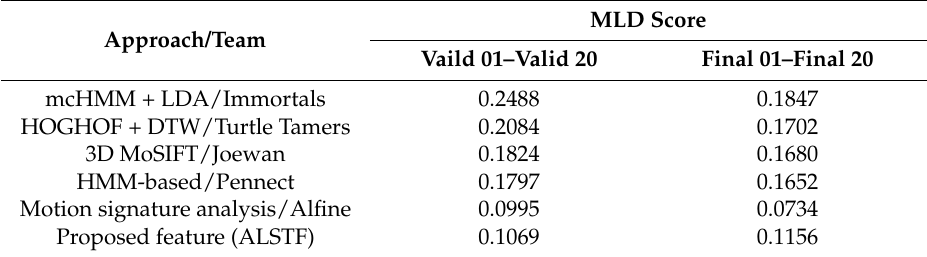
Table 5. The performance comparison with 5 state-of-the-art one-shot learning gesture recognition approaches on the valid and final (round 1: final 01–final 20)